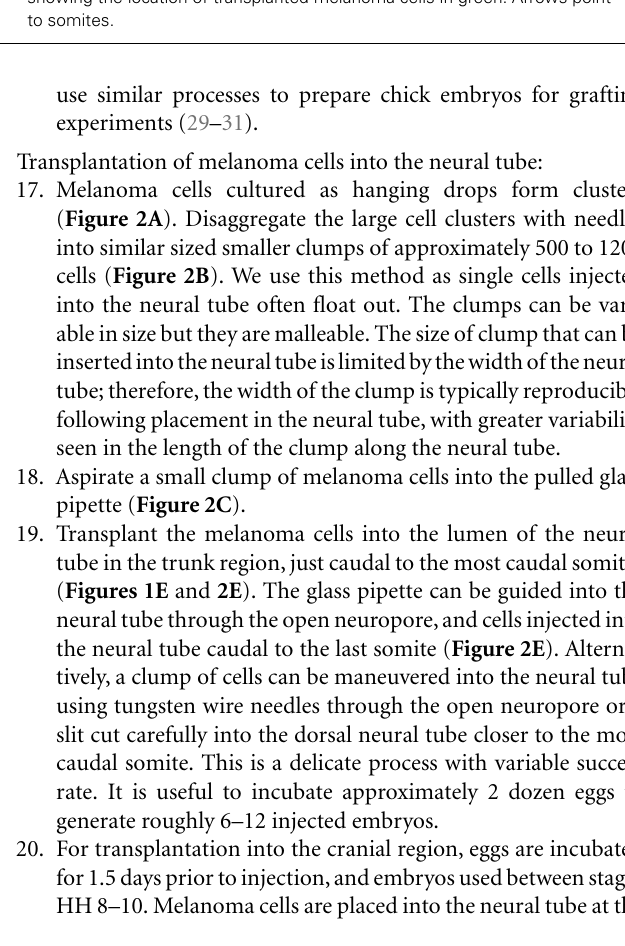
8. Incubate cells with labeling solution at 37°C for 20